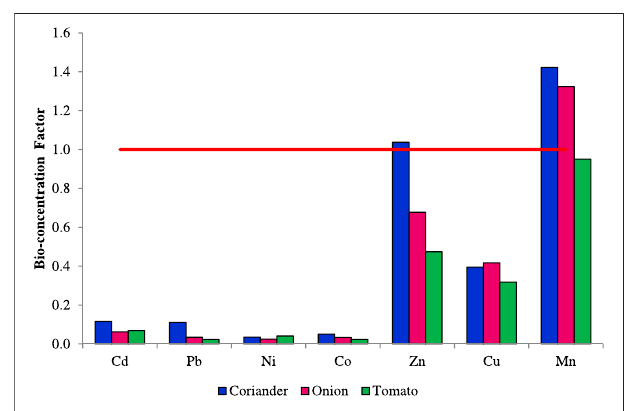
FIGURE 2 | Bio-concentration factor (BCF) of different heavy metals in different